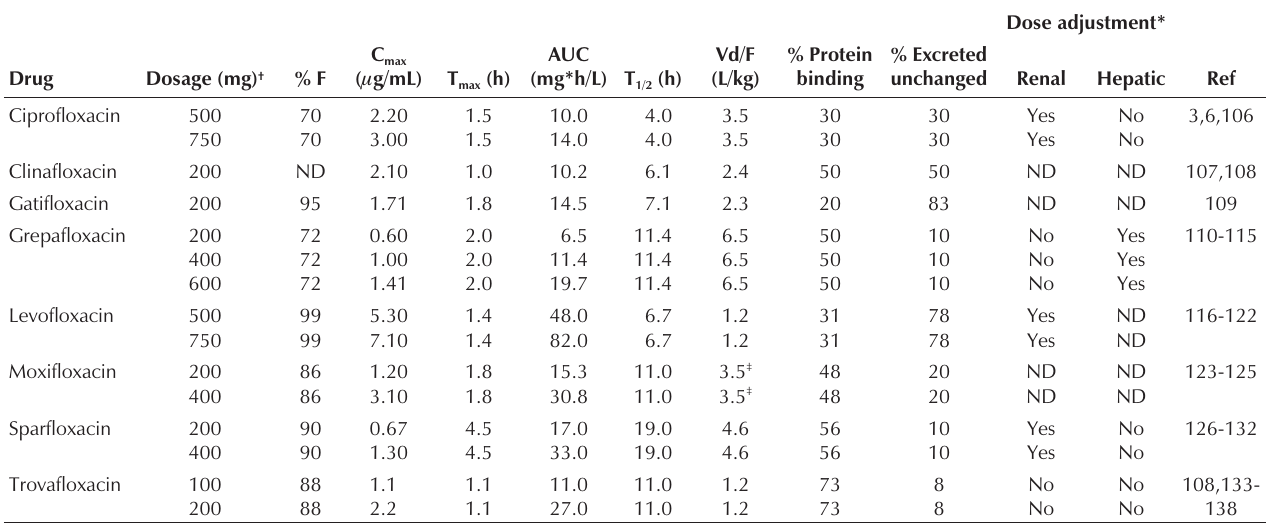
*Dose adjustment refers to whether or not the fluoroquinolone requires any dosage adjustments in patients with impaired renal or hepatic function. † Dos- age only applies to peak concentration reached in the plasma/serum (C max ) and area under the plasma concentration time curve (AUC). The other parame- ters represent an average of the values available in the literature irrespective of dosage. The dosages reported are based on the dosages commonly used in clinical trials for these drugs. ‡ Volume of distribution for moxifloxacin was approximated by dividing the literature value of 242 L by 70 kg. F Bioavailability;